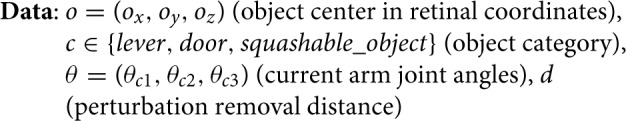
Learning causative actions.